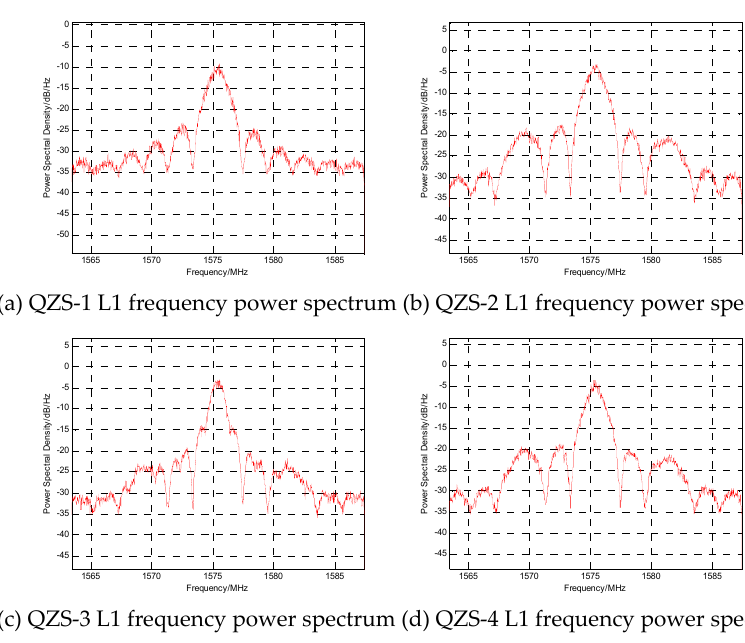
Figure 5. QZSS satellite L1 frequency point power spectra. Table 2. QZSS satellite L1 frequency signals composition